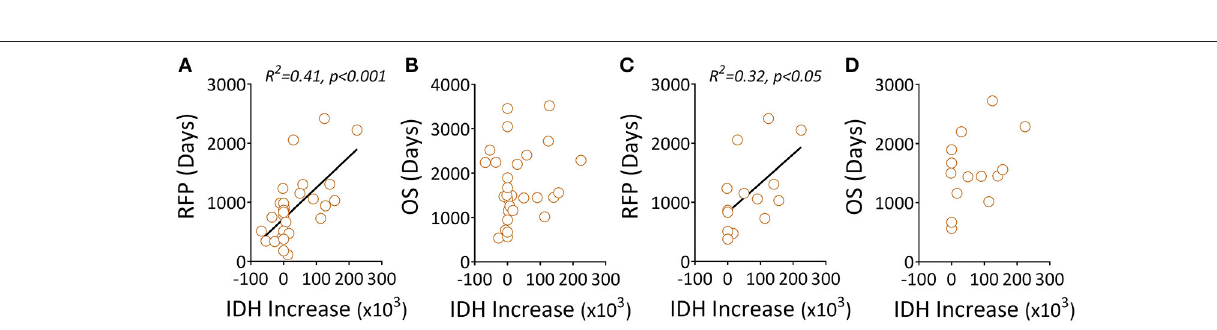
Frontiers in Molecular Neuroscience | www.frontiersin.org